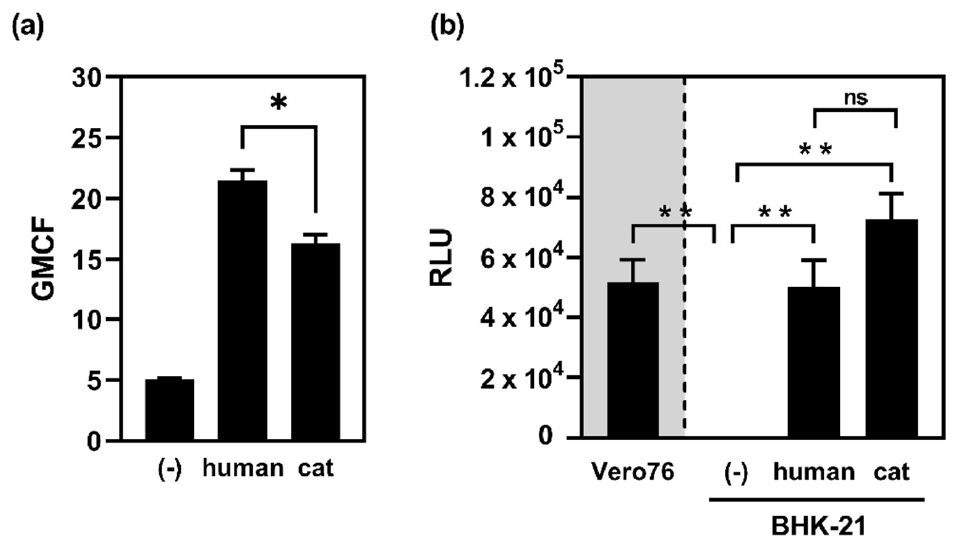
Figure 3. Feline ACE2 facilitates SARS-CoV-2 S-mediated entry: ( a ) surface expression of transiently expressed ACE2. BHK-21 cells were transfected for the expression of human or cat ACE2, empty vector served as control. ACE2 was stained by polyclonal antibodies directed against ACE2 and anti-goat Alexa Fluor ® 488-conjugated secondary antibodies. ACE2 expression was quantified by flow cytometry and is given as geometric mean channel fluorescence (GMCF). The graph shows the means and SEM of three independent experiments. Statistical significance was determined by paired, two-tailed t -test. *: p ≤ 0.05; ( b ) ACE2 expressing Vero E6 cells and BHK-21 cells lacking ACE2 expression served as positive and negative controls, respectively. Prior to transduction, BHK-21 cells were transfected for the expression of human or cat ACE2. Transduction was quantified by measuring luciferase activity and is given as relative luminescence units (RLU). The graph shows the means and SEM of three independent experiments performed as quadruplicates. Statistical significance was determined by paired, two-tailed t -test. **: p ≤ 0.01